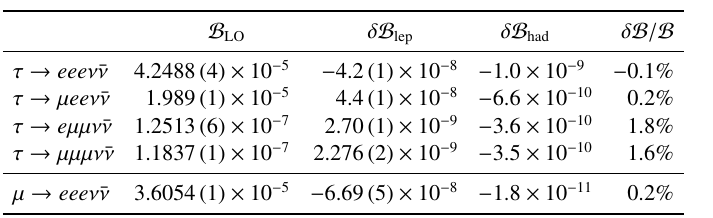
Table 2. LO and NLO branching ratios of τ → (cid:96)(cid:96) (cid:48) (cid:96) (cid:48) ν ¯ ν (with (cid:96),(cid:96) (cid:48) = e ,µ ) and µ → eee ν ¯ ν . The NLO correction due to photons and leptons only is denoted by δ B lep , while the non-perturbative contribution given by the hadronic vacuum polarization is denoted by δ B had . The last column report the ratio between the NLO correction and the LO branching ratio. The uncertainties are the error due to numerical